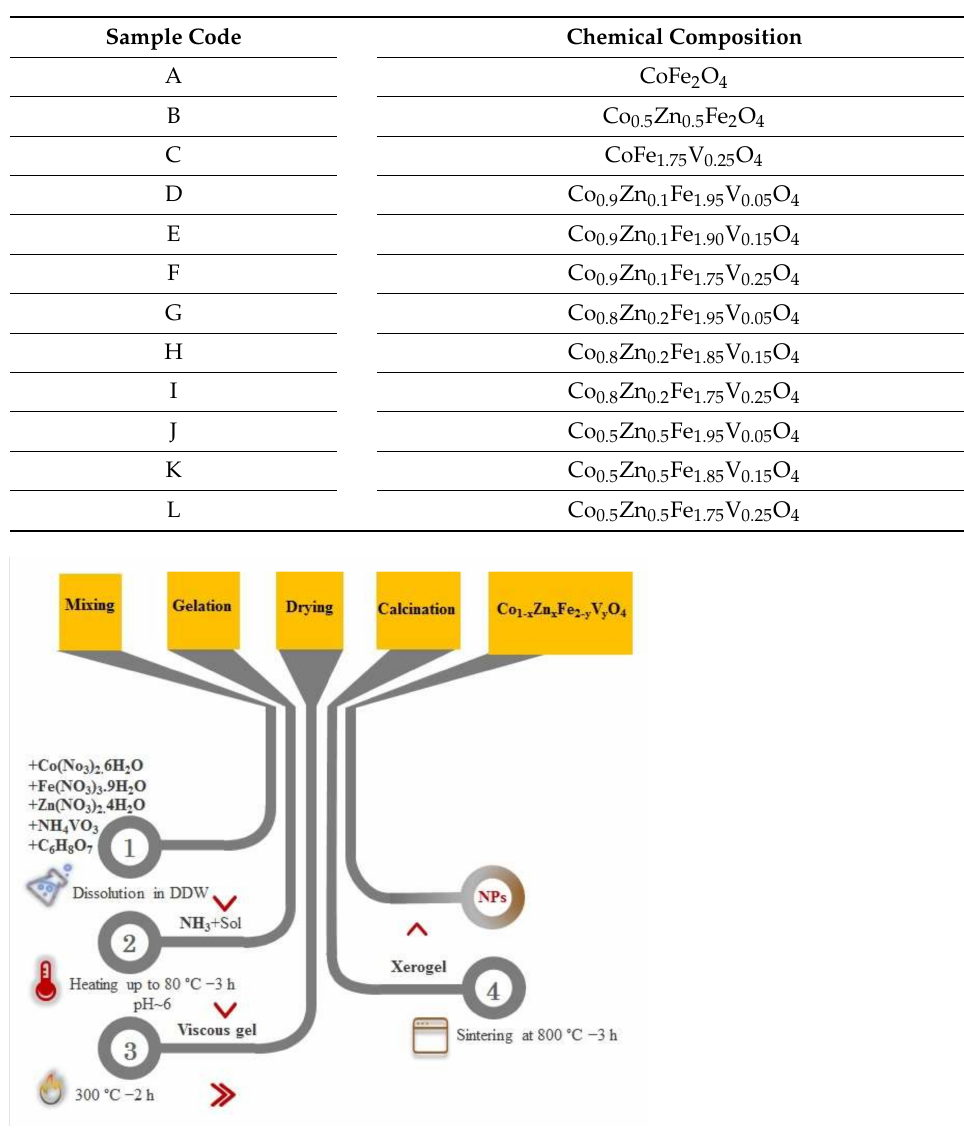
Table 1. Chemical composition of the synthesized samples.